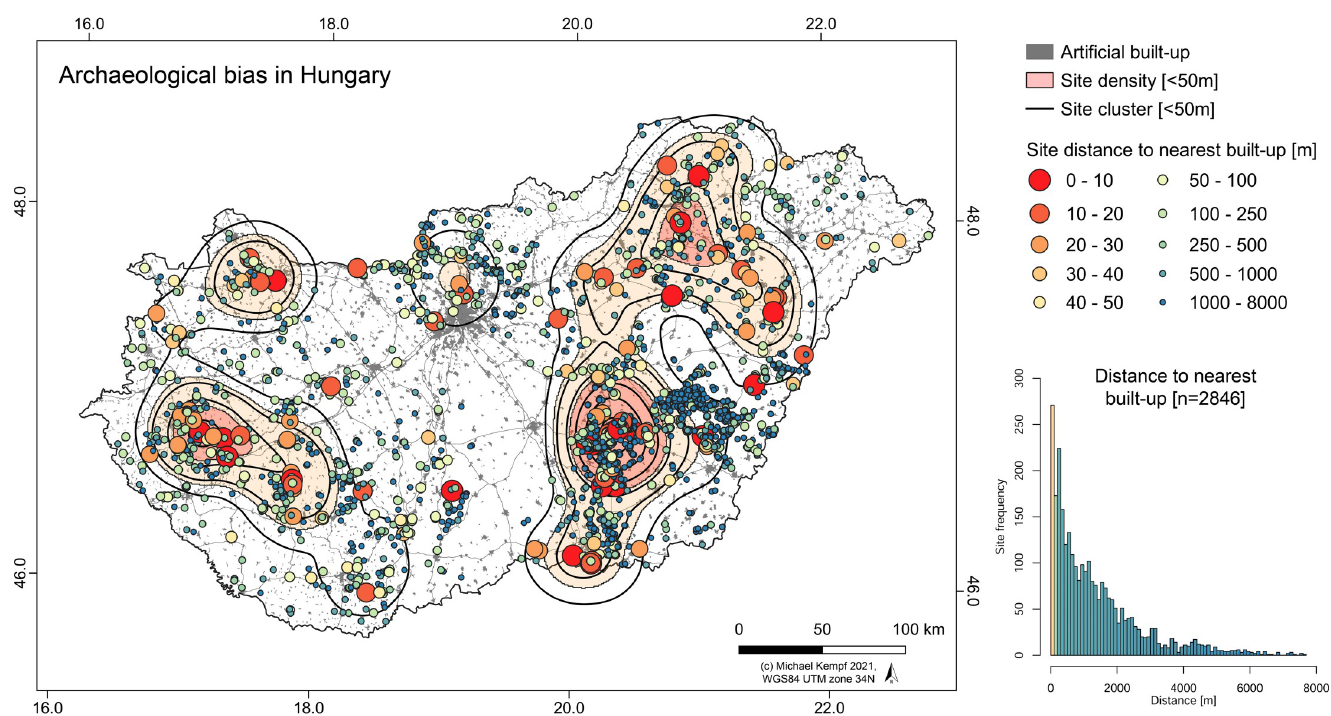
Fig 13. Archaeological bias in Hungary. Spatial relationships between sites located outside of the current built-up and infrastructure mask (n = 2846) and the distance to the nearest artificial surfaces. Density estimates of the sites located within a 50 m distance to the nearest built-up are given in red color and contours. Close distance is highlighted by large size and red color, far distance in small circles and blue color. The histogram shows the distribution of the distance values.